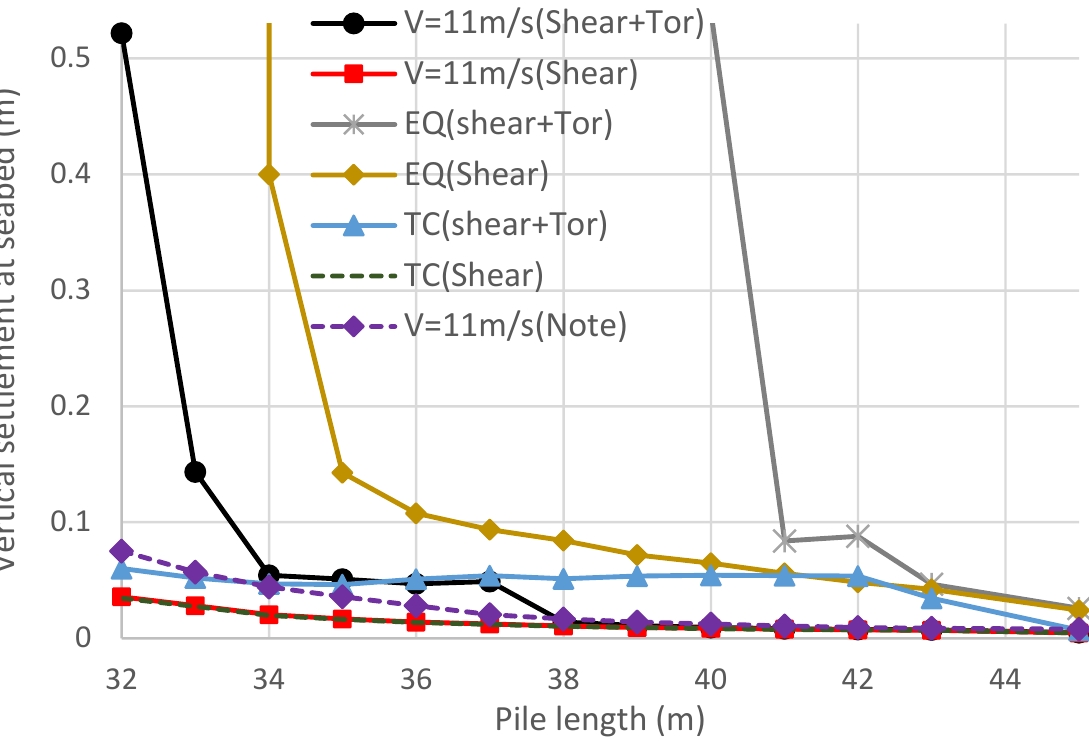
Figure 6. The changes in the pile vertical displacement in the sea bed with the used pile length for the 10 MW case under the loads of DLC 1.1 ( V hub = 11 m/s), DLC 1.8 (0.32 g earthquake and V hub = 11.4 m/s), and DLC I.2 (Tropical cyclone V hub = 72 m/s) (Note = (Shear + Tor) the yaw stiffness equal to 3 × 10 5 kN-m/rad).